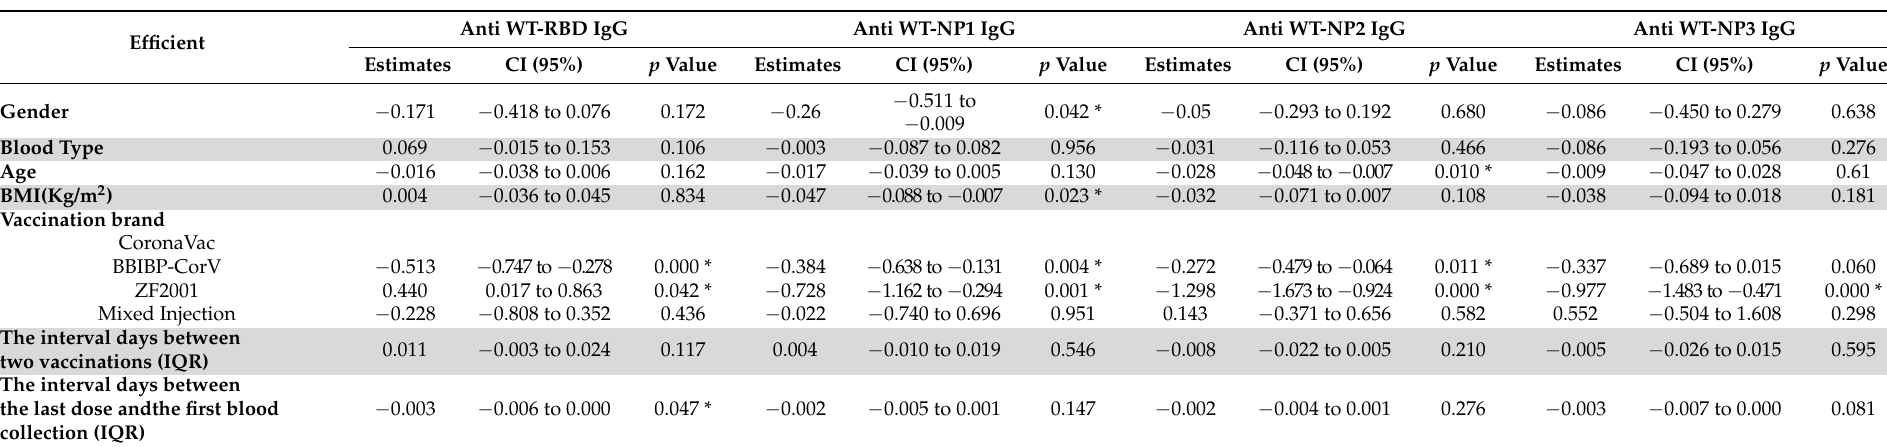
Table 2. Univariate linear regression models of WT-Ab (IgG) immune